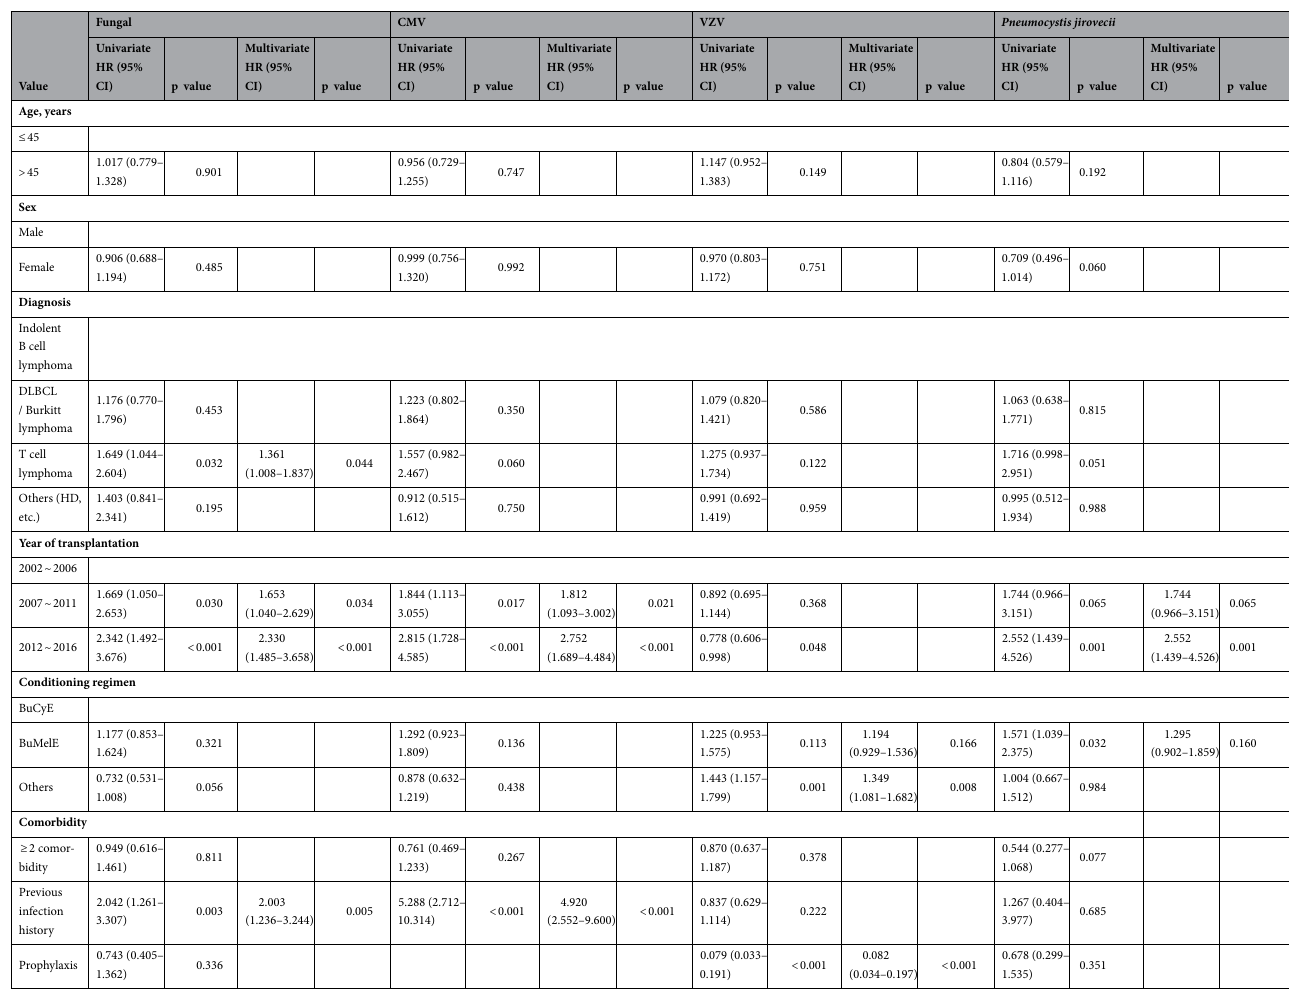
Table 2. Univariate and multivariate Cox analysis for atypical infection in lymphoma. CMV Cytomegalo virus, VZV Varicella zoster virus, HR hazard ratio, CI confidence interval, DLBCL diffuse large B cell lymphoma, HD Hodgkin’s disease, BuCyE Busulfan and Cyclophosphamide and Etoposide, BuMelE Busulfan and Melphalan and